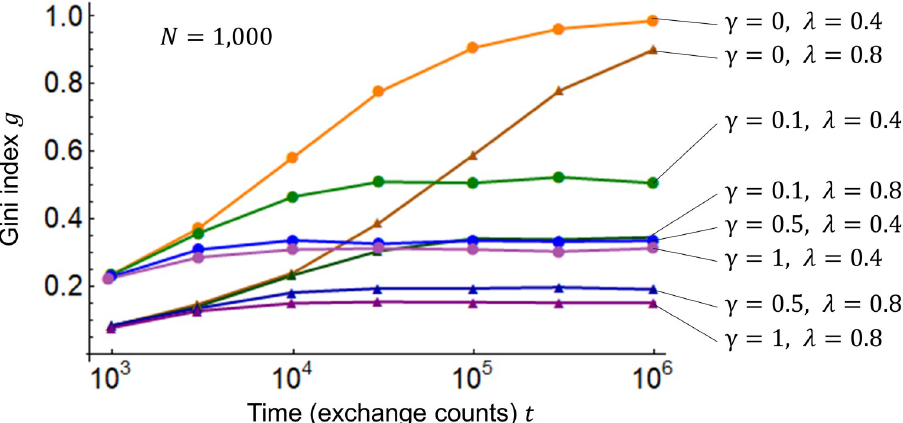
Fig 3. Gini index g for saving rate λ and surplus contribution rate γ of the wealthy. The horizontal axis represents time t while the vertical axis represents the Gini index g . The number of agents N = 1,000, and the initial values of assets m (0) = 1 are the same as those of Fig 2. Two different saving rates, λ = 0.4, 0.8, and four different surplus i contribution rates of the wealthy, γ = 0, 0.1, 0.5, 1, for a total of eight cases, are simulated.